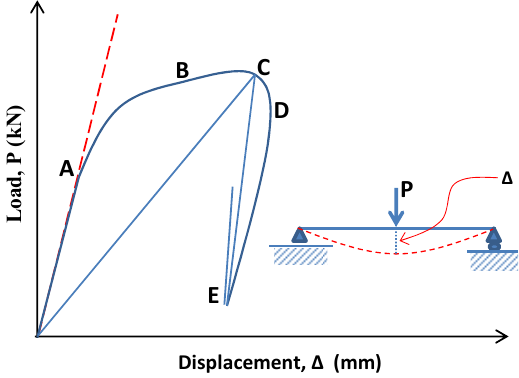
Figure 1. The load vs. deflection relationships of the reinforced concrete beam [15].